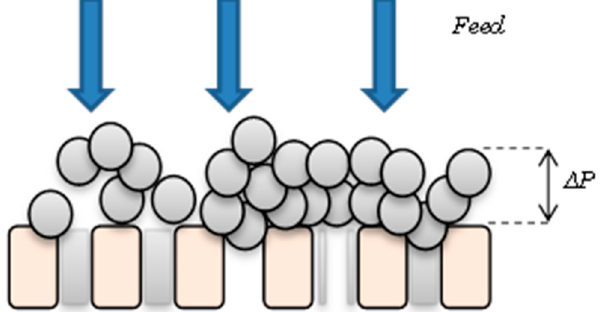
Figure 1. Diagram of the combined fouling mechanisms. Colloids or small particles constrict the pores while larger particles blocked them, forming a